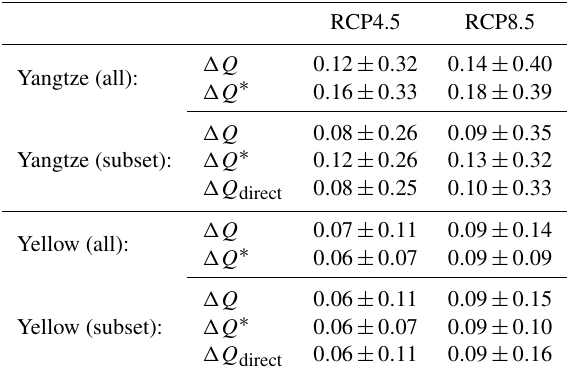
Table 1. CMIP5 model-simulated ( (cid:49)Q ) and CMIP5 Budyko- corrected ( (cid:49)Q ∗ ) future-minus-present runoff changes (mmday − 1